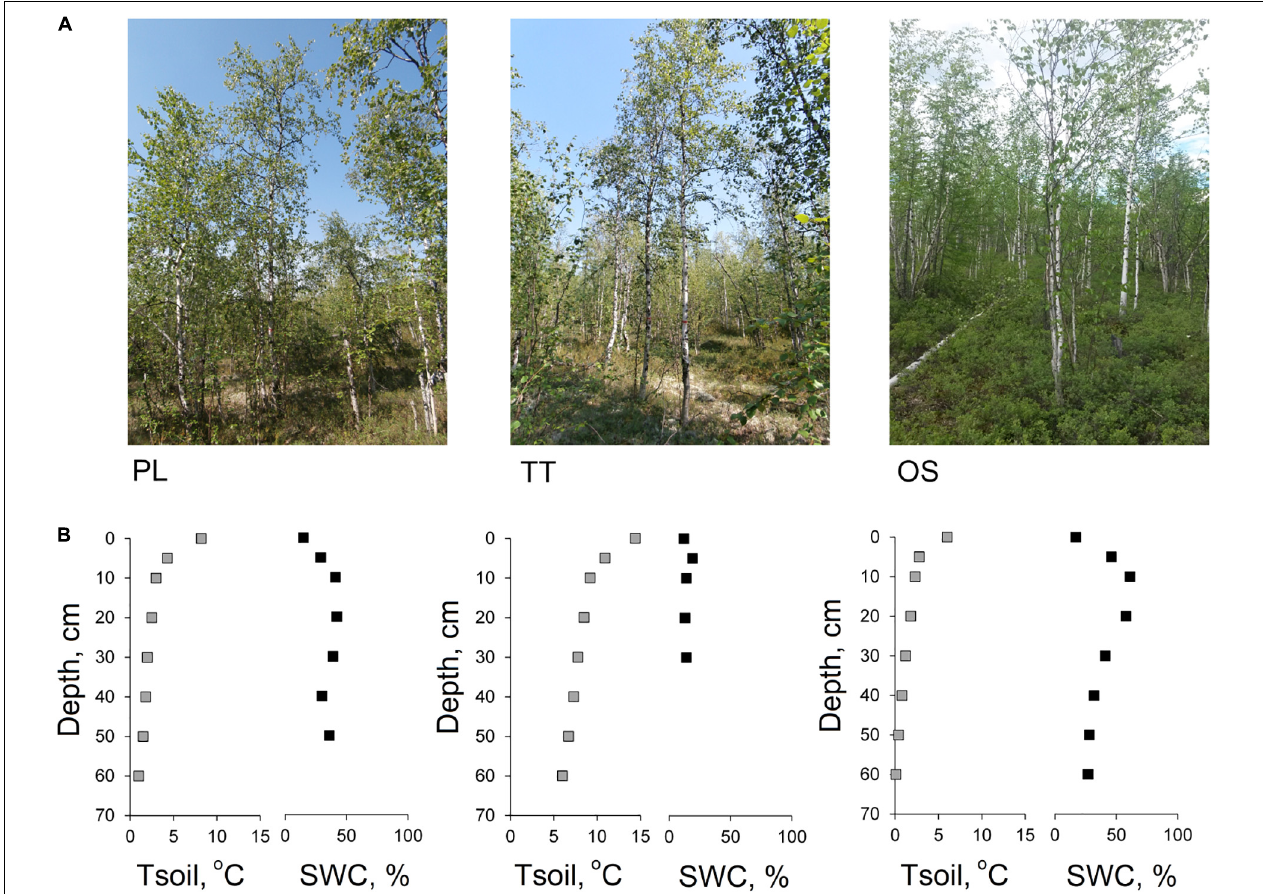
FIGURE 1 | Photograph of the fire-origin birch stands (PL—110 years old, TT—114 years old, OS—54 years old) (A) , and 60-cm-depth profiles of soil temperature (Tsoil—gray square) and gravimetric soil water content (SWC—black square) obtained in the middle of the growing season (B) .